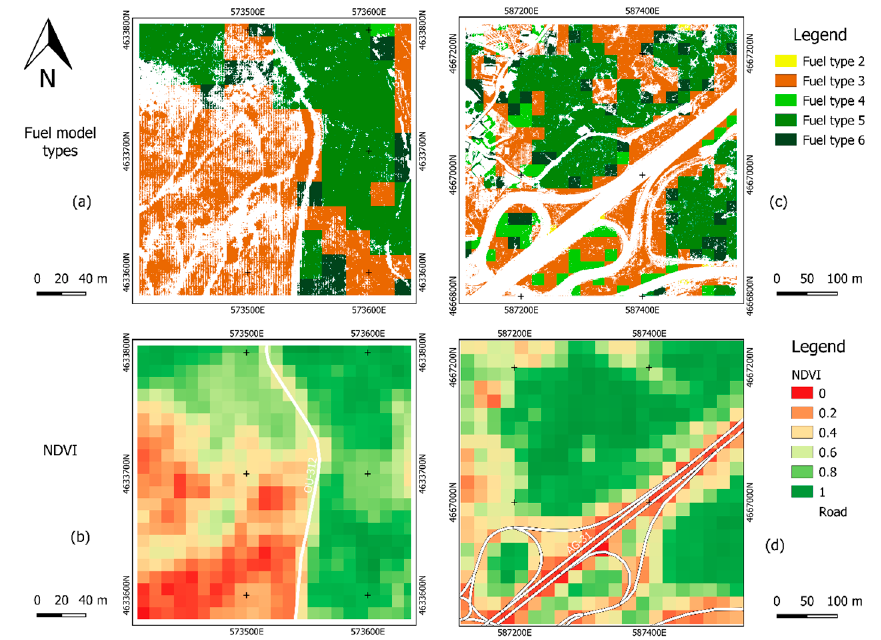
Figure 5. Fuel models type and NDVI maps. ( a ) Map of fuel model types of study area A; ( b ) NDVI map of study area A; ( c ) map of fuel model types of study area B; ( d ) NDVI map of study area B. The map coordinate system is EPSG:25829 ETRS89/UTM zone 29N.